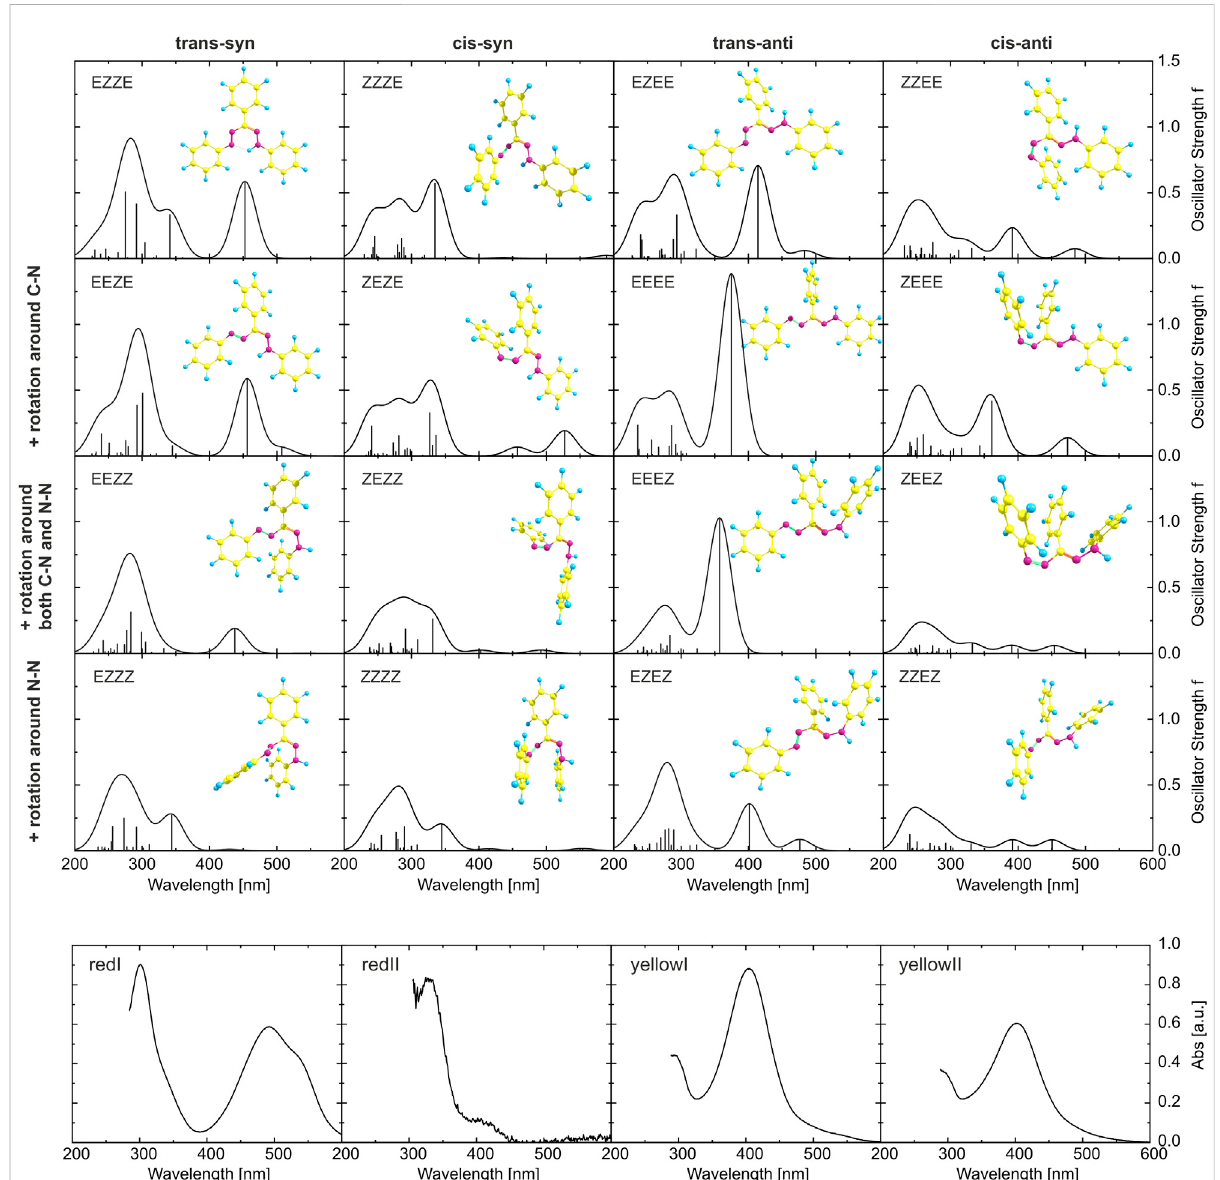
FIGURE 6 Top 16 panels: Results from DFT calculations for the16 isomers considered in this study. The optimized ground-stategeometriesare displayed together with the calculated absorption spectra (the oscillator strengths at the corresponding transition energies are given as stick spectrum convoluted each with a Gaussian of a 40 nm width at half maximum). The orientations with respect to the N=N and C=N double bonds are identical within each column, whereas the ones with respect to the C – N and N – N single bond are the same for each row. Bottom 4 panels: Experimentally determined spectra of the four isomers corresponding to the double-bond orientations given at the top of each column. The red I spectrum is the ground-state absorption spectrum of a toluene solution, yellow I was measured directly after illumination with 455 nm of a toluene solution, yellow II corresponds to the photostationary state in toluene induced by 455 nm light (Wortmann et al., 2022), and red II is estimated by subtracting the GSB from the pink DADS in Figure